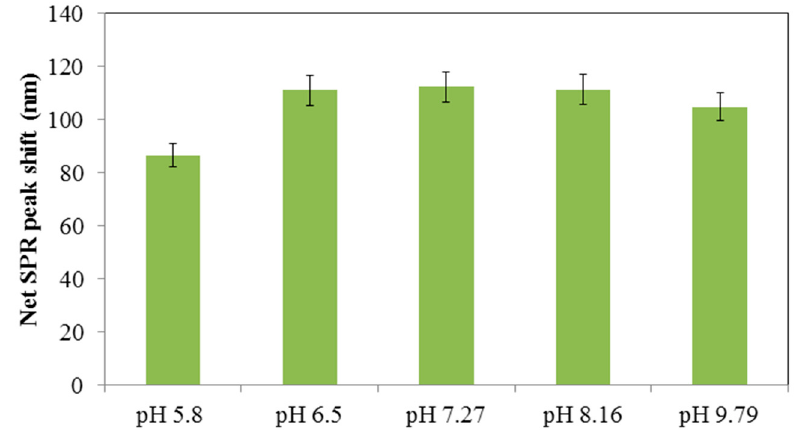
Figure 7. Influence of pH on the extent of the SPR peak shift at 5 µM of Hg 2+ in 5 mM phosphate buffered saline.